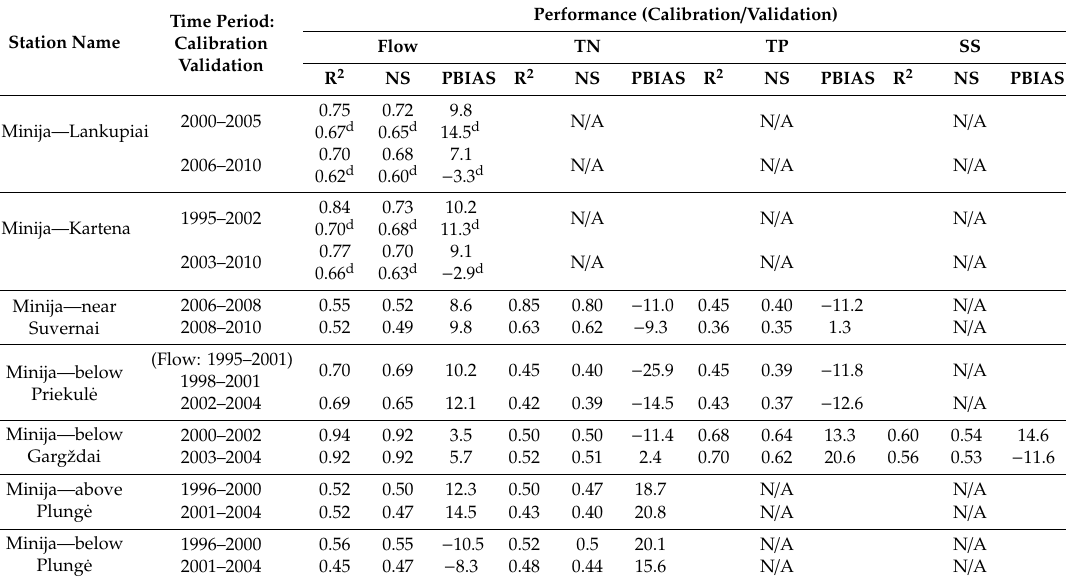
Table 4. Monthly model performance statistics for every